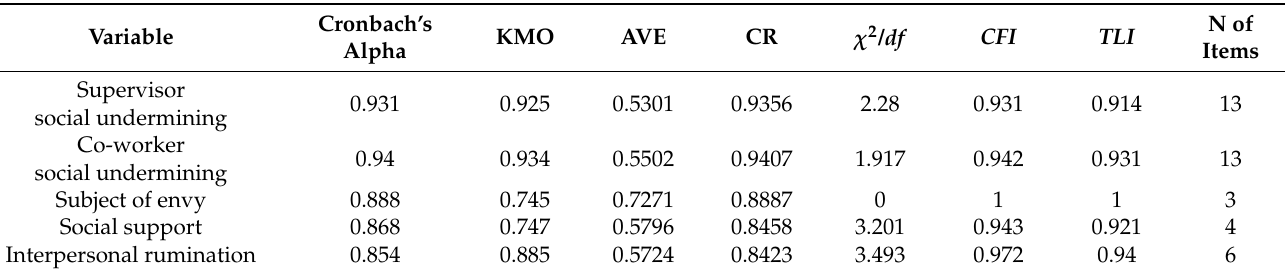
Table 4. Statistical results of some